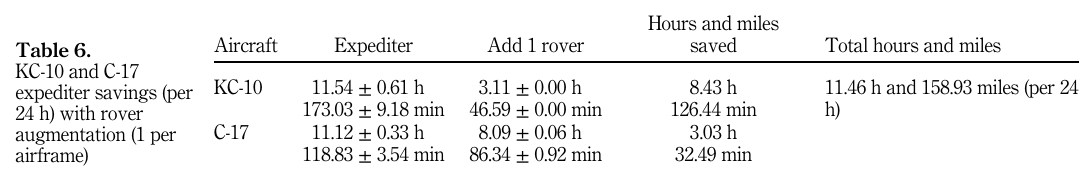
expediter savings (per 24 h) with rover augmentation (1 per